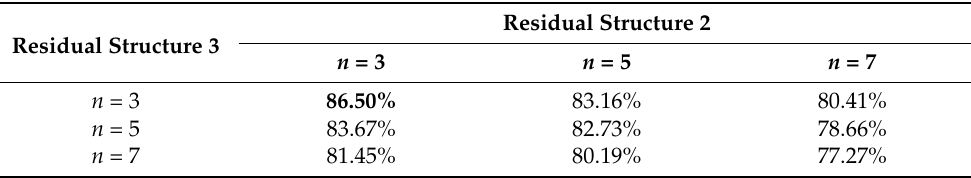
Table 3. The recognition accuracy of different network structures on dataset 2a (n represents the size of the convolutional kernel).